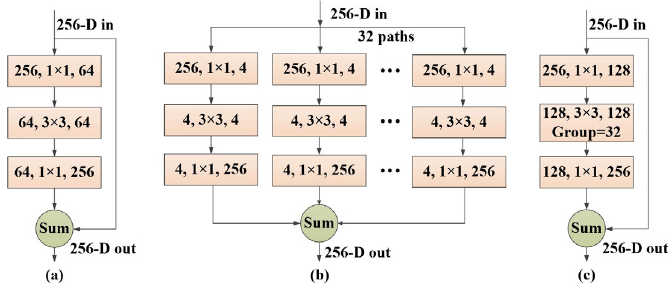
Figure 3. The basic structures of ResNet and ResNeXt. (a) the basic structure of ResNet. (b) the basic structure of ResNeXt. (c) the grouped convolution structure of ResNeXt.